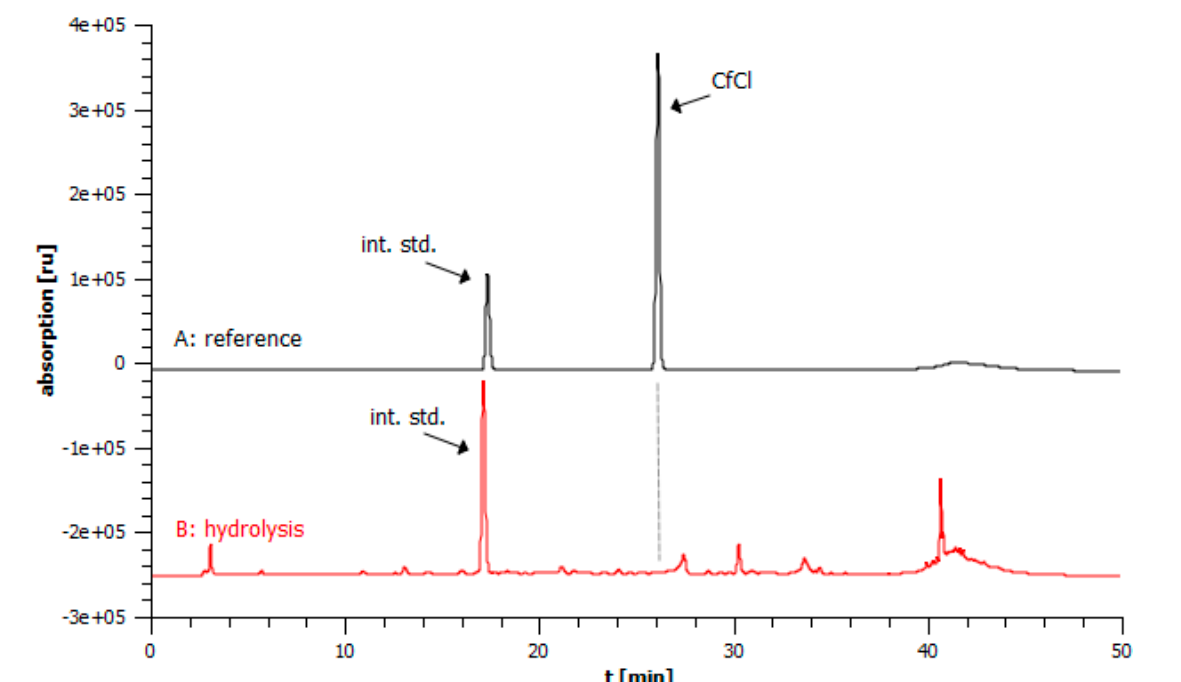
Figure 3. ( A ). Reference HPLC chromatogram of prepared dry suspension of cefaclor (CfCl) with paracetamol as internal standard (int.std.). Further method details can be found in the SI. Retention times rt CfCl = 26.1 min, rt int. std. = 17.5 min. ( B ). Sample mixture of CfCl and int.std. was stirred for 20 min with the same volume of 0.4 M NaOH, which quantitatively hydrolyzed cefaclor. LC/MS analysis of the degradation products can be found in the Supplementary Materials. Table 1. Parameters for the alkaline hydrolyzation of the prepared cefuroxime β‐ lactam dry suspension formulation. For each time point, three independent experiments were performed. * cv = coefficient of variation.